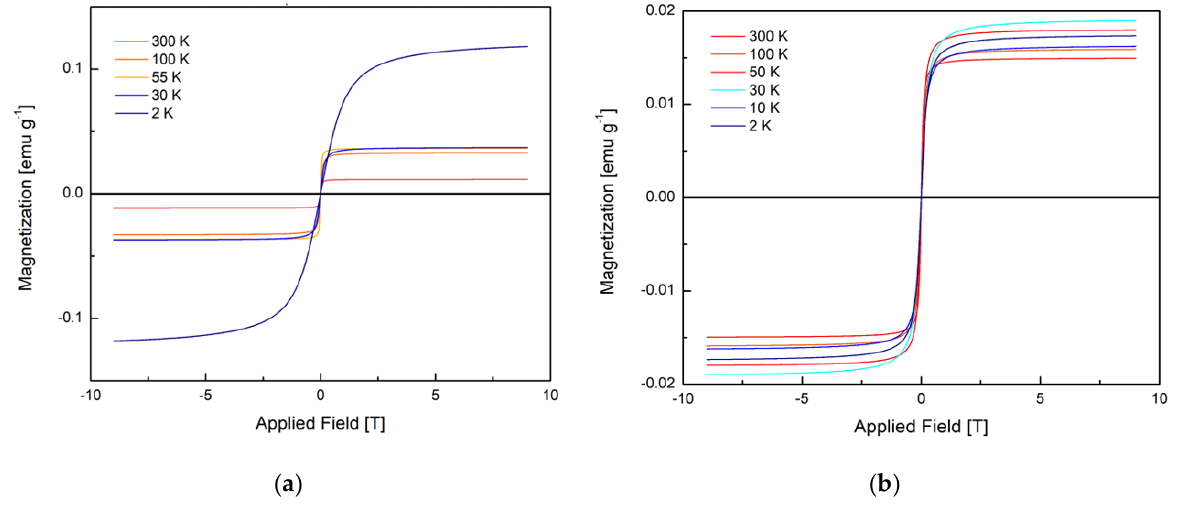
Figure 6. ( a ) Magnetization curve of sample 1 (smaller rods) from 2 to 300 K; ( b ) magnetization curve of sample 2 (larger rods) from 2 to 300 K. It is important to note the difference in the magnitude of the magnetization between